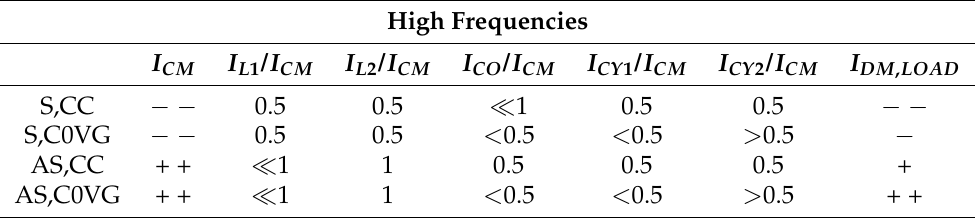
Table 2. Comparison for the different filter configurations studied here of the magnitudes of the expected currents flowing at the output filter, as represented in the circuit model in Figure 4. This comparison assumes that frequency is sufficiently high as to make significant the effect of parasitic in- ductances. Signs + and − in the table account for comparatively high and low currents,